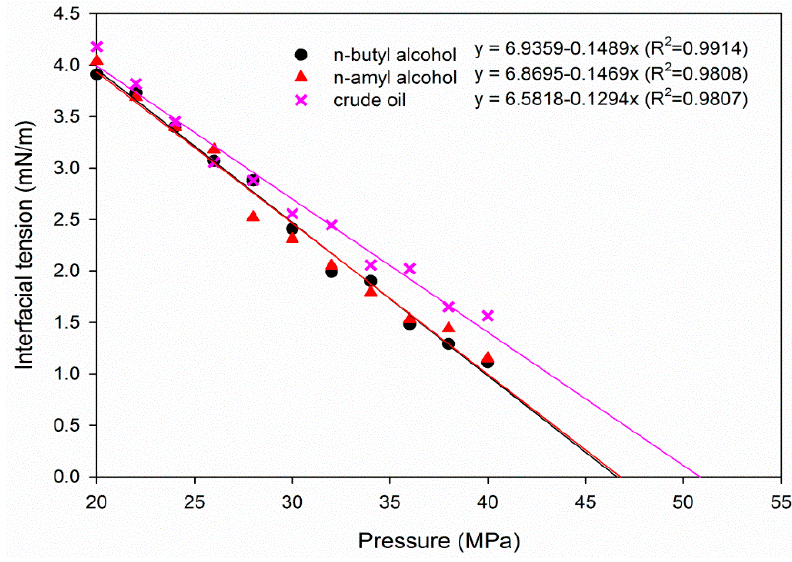
Figure 8. Changes of CO 2 –oil IFTs with pressures for the crude oil diluted with different alcohols.